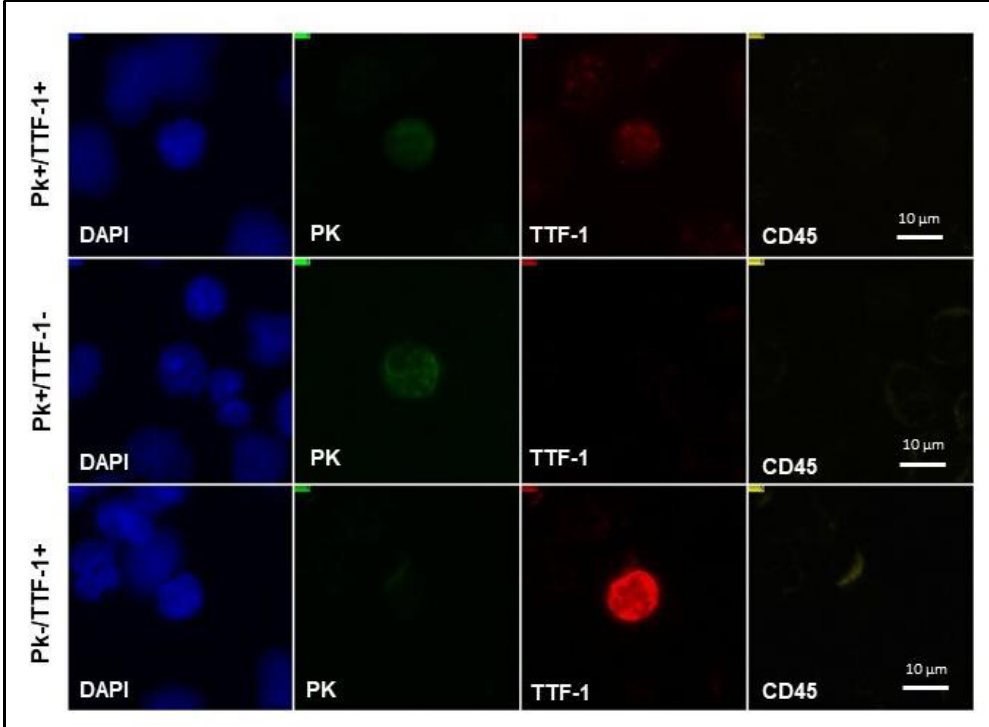
Figure 4. NSCLC CTC subpopulations detected on SBS-CTCs slide. Representative images of CTCs with various biomarker profiles detected on SBS ® slide in NSCLC patients’ blood. NSCLC, non-small cell lung cancer; CTCs, circulating tumor cells; SBS ® slide, Smart BioSurface ® slide; PK, pan-cytokeratin; TTF-1, thyroid transcription factor- 1; DAPI, 4′ -6-diamidino-2-phenylindole. Ninety-five percent (n = 21) of tested patients expressed both PK and TTF-1, with a mean PK+/TTF-1+ value per mL/blood of 5.4 (range 0.4 – 22.2). Specifically, all 13 patients tested with CTC count > 3/mL blood were TTF-1 positive on liquid biopsy, although there was no statistically significant difference with patients with a CTC count < 3/mL ( p =